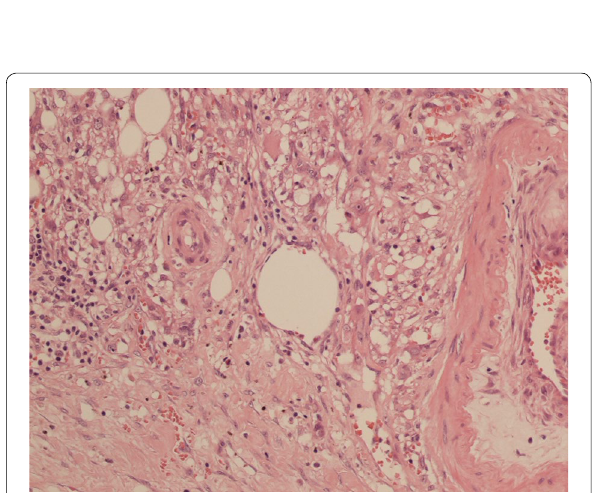
Fig. 3 Tumour with epithelioid cells, fat and blood vessels. Haematoxylin and eosin staining (